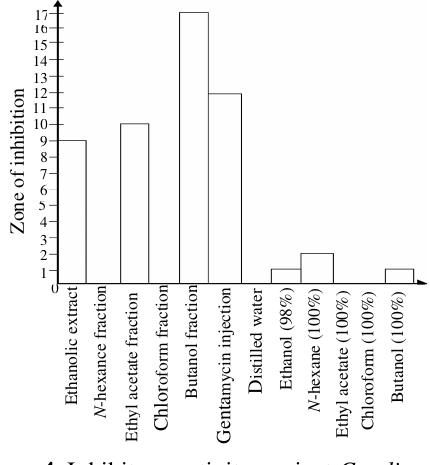
Figure 4. Inhibitory activity against Candia albicans .